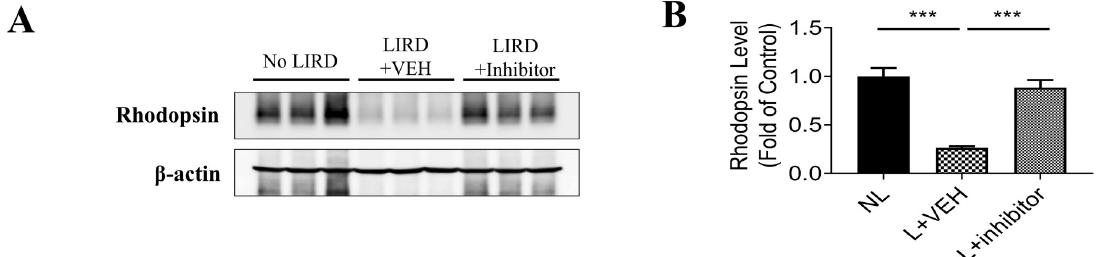
Fig 6. Analysis of rhodopsin level in LIRD mice treated with ( ± )-RPE65-61. LIRD caused the degeneration in the retinal photoreceptor cells and decrease of rhodopsin levels, which was preserved by inhibitor at the dose of 2 mg/kg in BALB/c mice. (A) Expression levels of opsin in the retinas of control and LIRD mice were measured using anti-rhodopsin (1D4) antibody. (B) Opsin monomer level was analyzed by densitometry and normalized by β -actin level. Data expressed as mean ± SEM. n = 4 per group. Student’s t-test. � P < 0.05, �� <